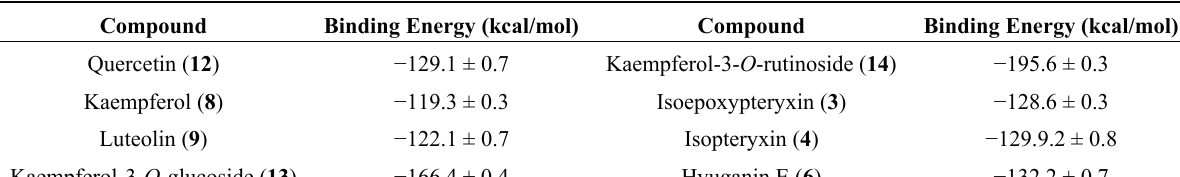
Table 2. Docking score of active compounds in AChEI assay.